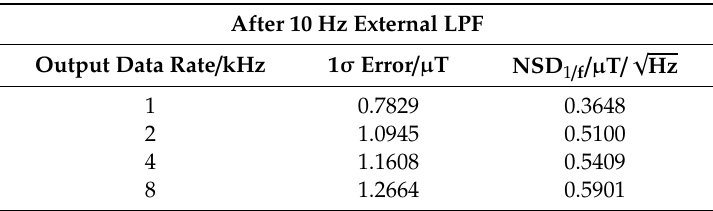
Table 6. O ff set fluctuation and drift noise performance figures for the bandwidth of 0.1–10 Hz. NSD 1 / f : noise spectral density at 1 Hz.